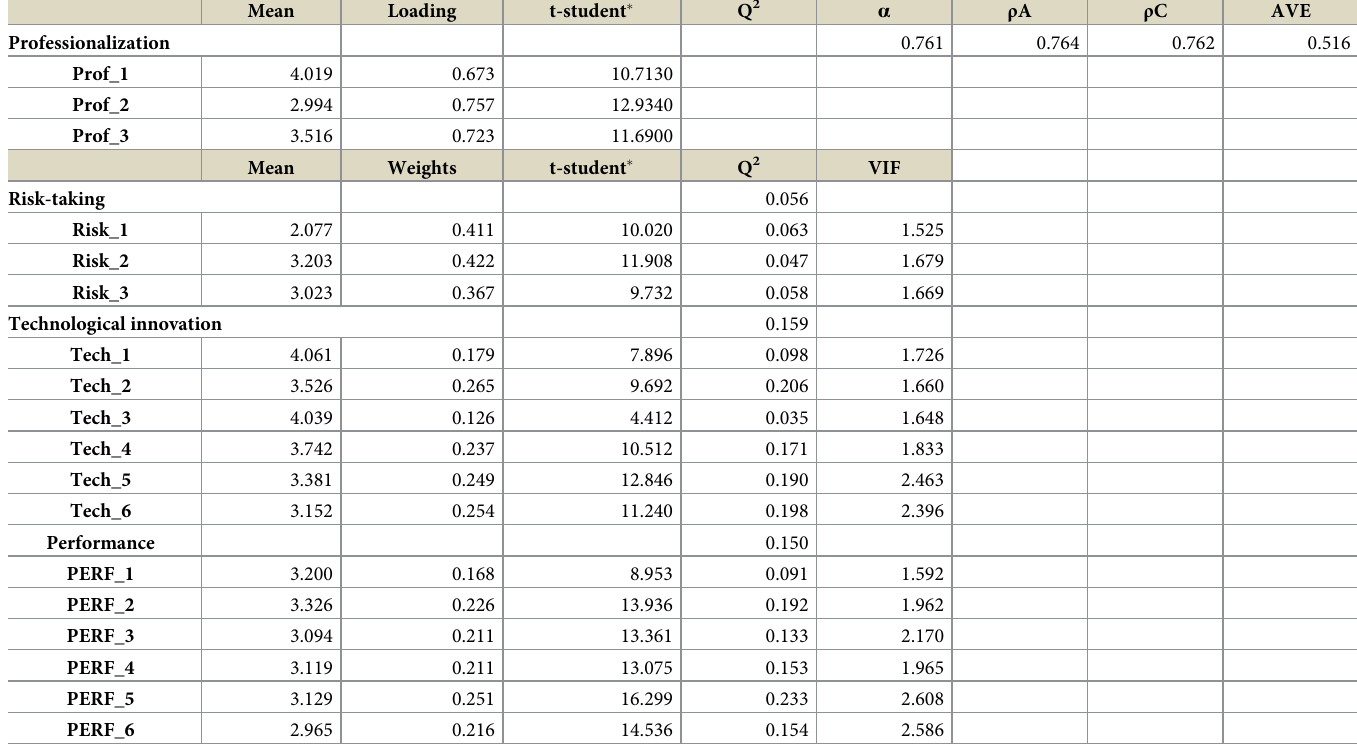
Table 4. Measurement model